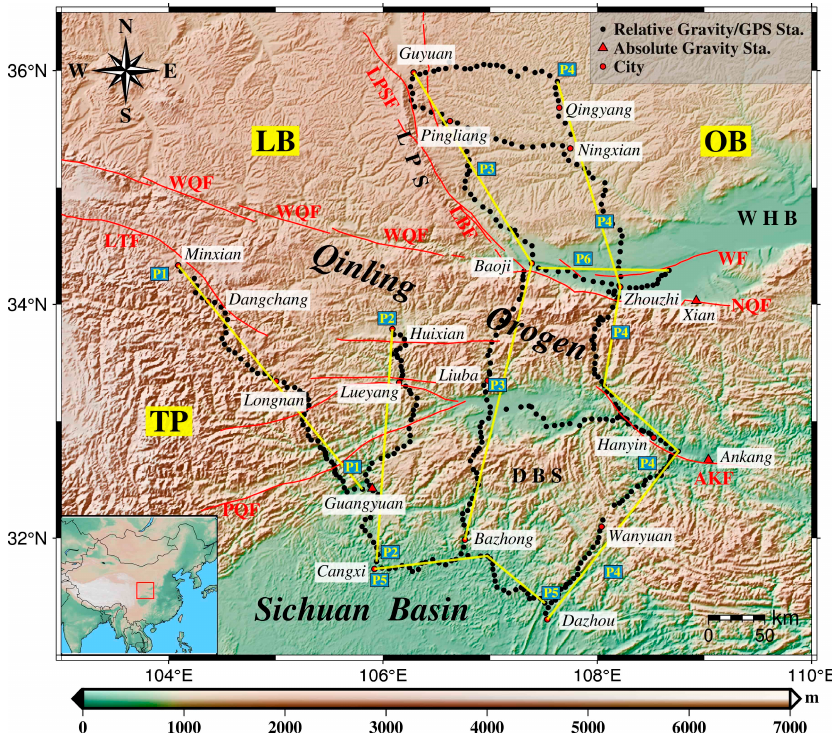
Figure 1. Map of the study area showing topography and the distribution of the gravity/GPS stations in the Qinling Area. The red square in the subfigure in the bottom left corner shows the geographical position of the study area in China. The black dots indicate the geographical positions of the measurement stations. Red triangles denote absolute gravity stations. Red dots denote cities.